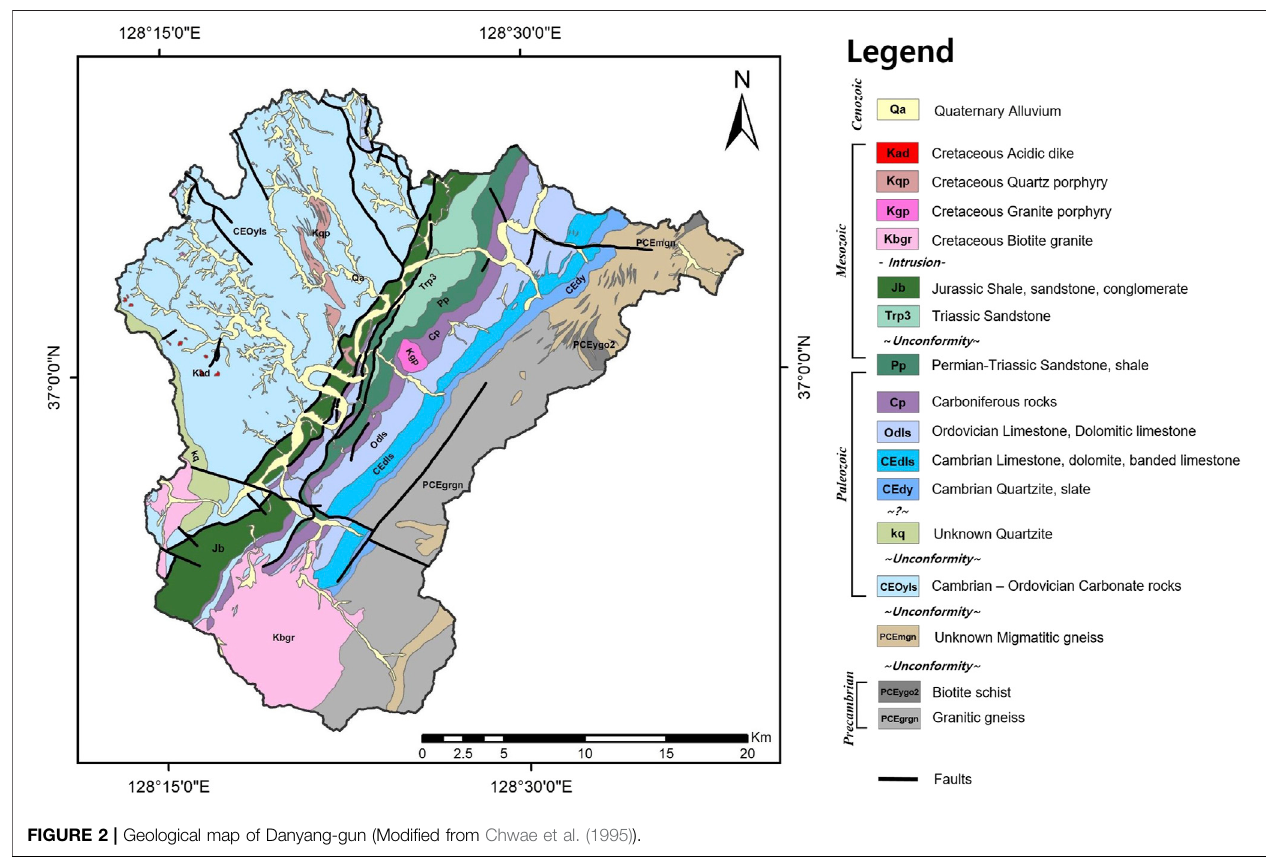
FIGURE 2 | Geological map of Danyang-gun (Modi fi ed from Chwae et al. (1995)).